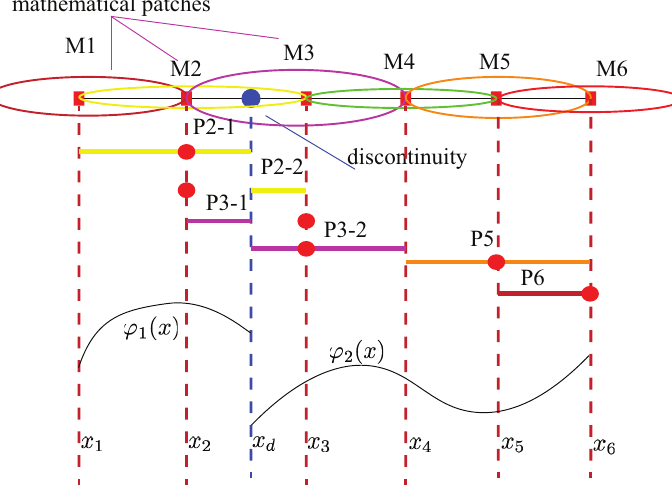
Figure 2. Local approximation to a discontinuous function ϕ ( x )